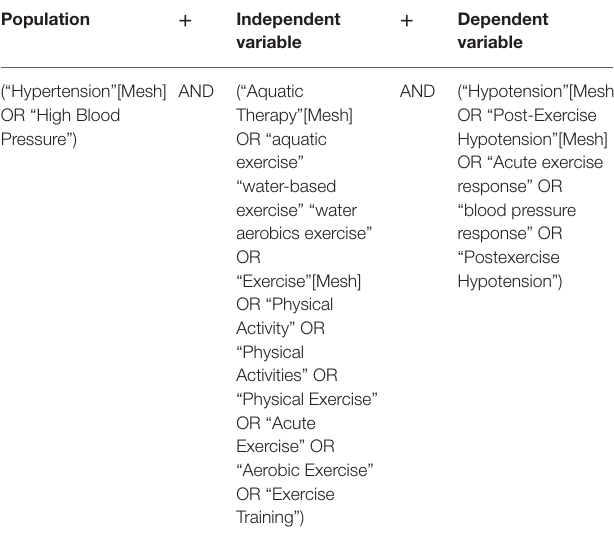
TABLE 1 | Search strategy